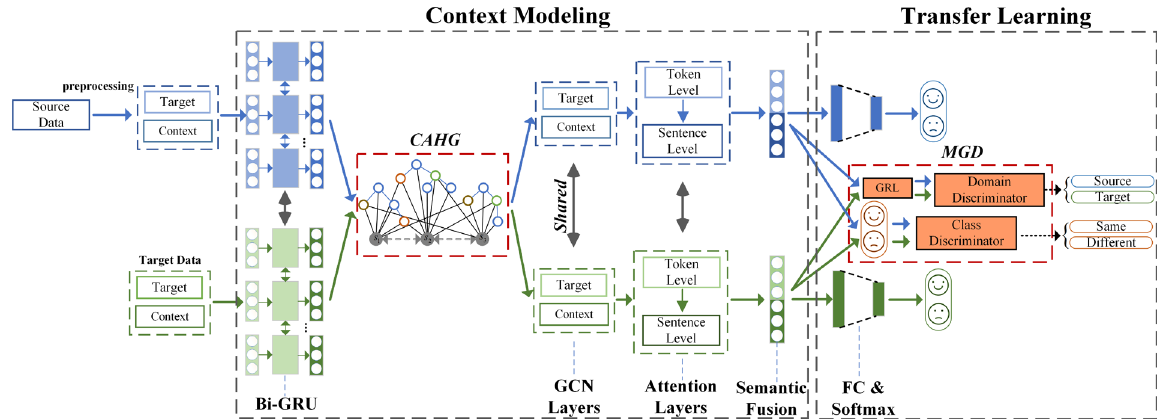
Figure 3. Overview of the context-aware semantic adaptation network. CAHG represents the context background structure in both the source and target domains. Attention layers are hierarchical attention, token-level of target sentence, and sentence-level of context background. There are two layers of GCNs. MGD represents the proposed multigrain discriminator. Details on the CAHG and MGD are discussed in later